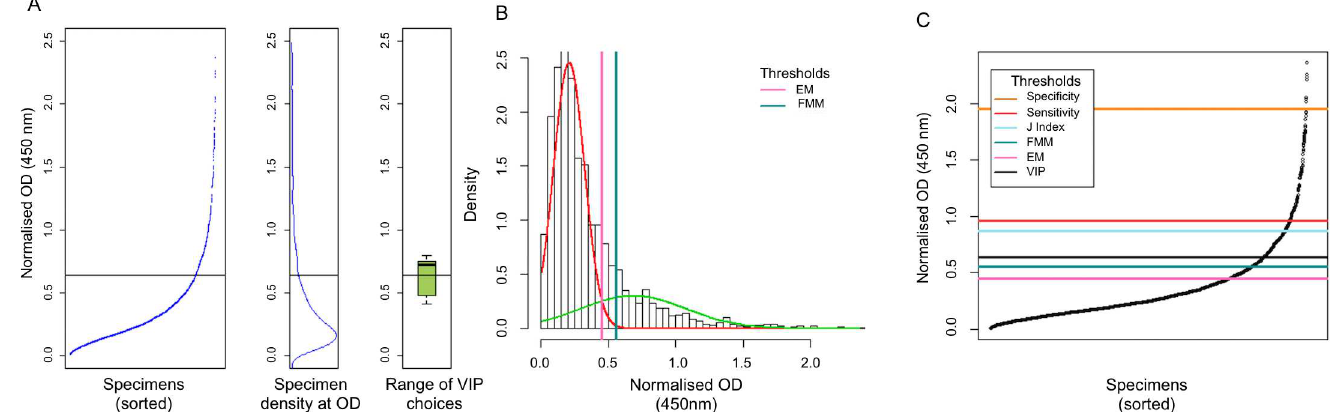
Fig 3. Threshold values for Uganda (1–9 year olds) data. Panel A shows the threshold as determined by visual inflection point analysisby 12 volunteerindividuals,as detailedin Fig 2. Panel B shows the thresholdsset by the finite mixture model and expectation-maximisation algorithm, as describedin Fig 2. Panel C compares the threshold specifications by four different methods. Scatterplots show the normalised and sorted OD 450 values with horizontallines markingthe thresholds specifiedby VIP (OD 450 = 0.641), EM (OD 450 = 0.450), FMM (OD 450 = 0.554), ROC curve maximising Youden’sJ-index (OD 450 = 0.870), ROC curve with sensitivity > 80% (OD 450 = 0.968) and ROC curve with specificity > 98% (OD 450 = 1.951).